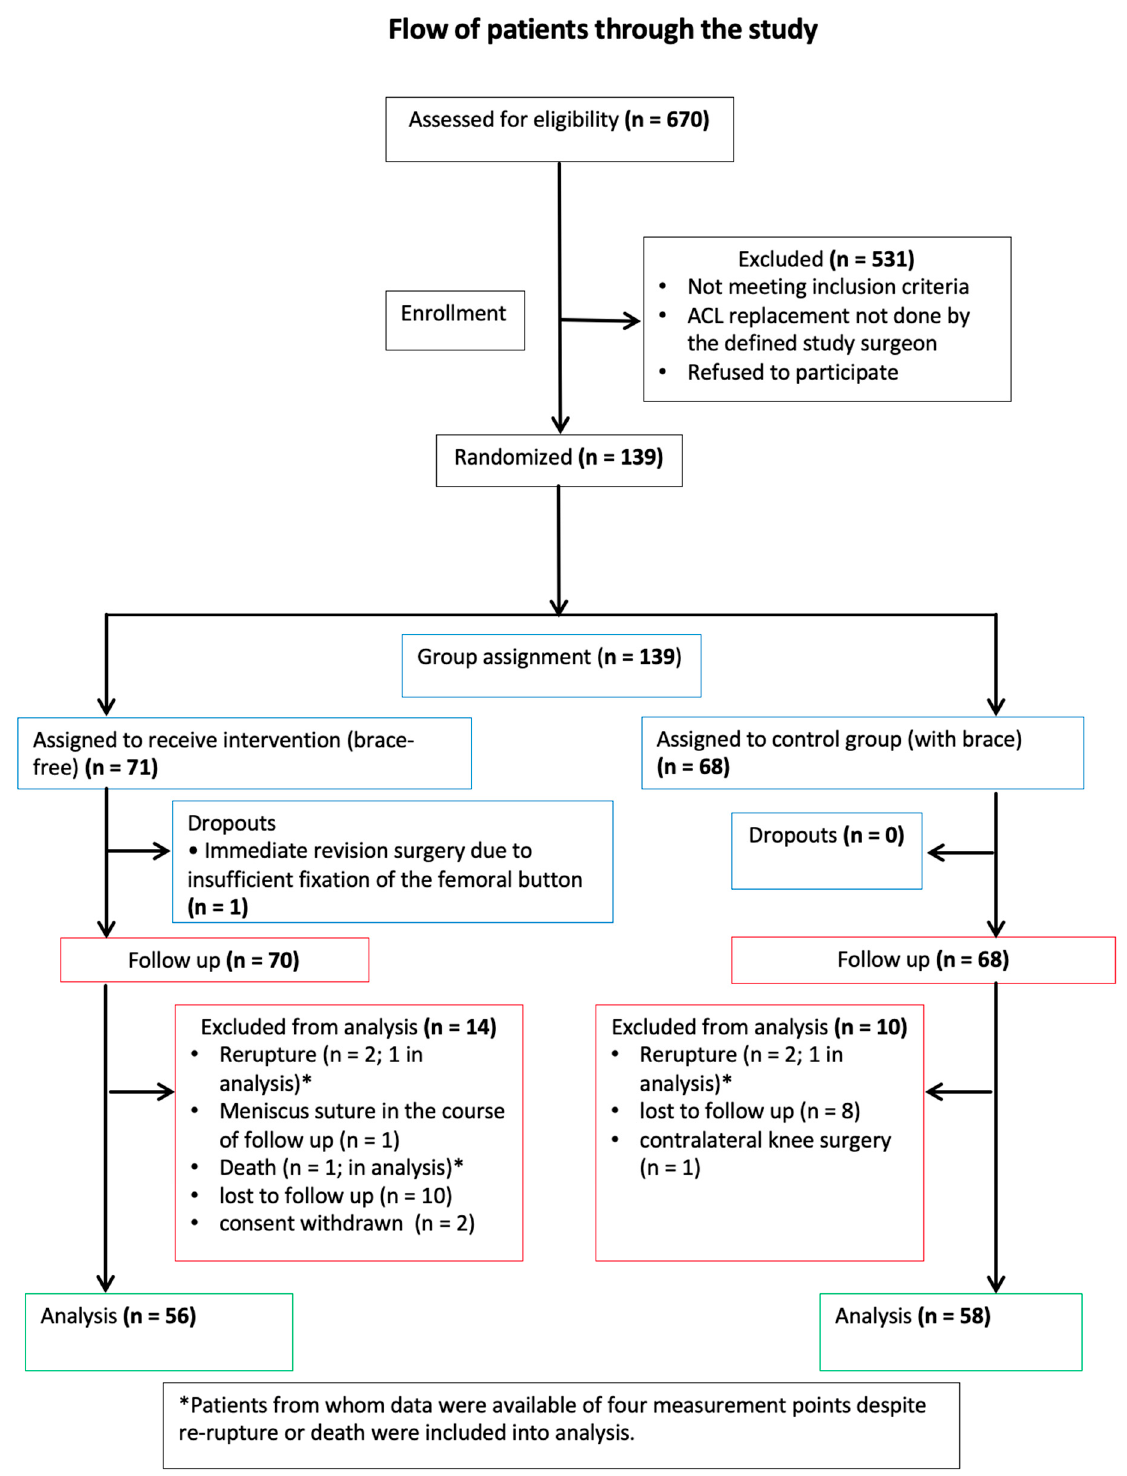
Figure 2. Patient inclusion flowchart. ACL, anterior cruciate ligament. Complications occurring post-randomisation are listed in Table